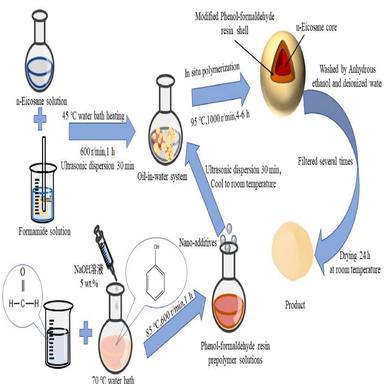
Preparation principle and flow chart of modified MicroEPCM.